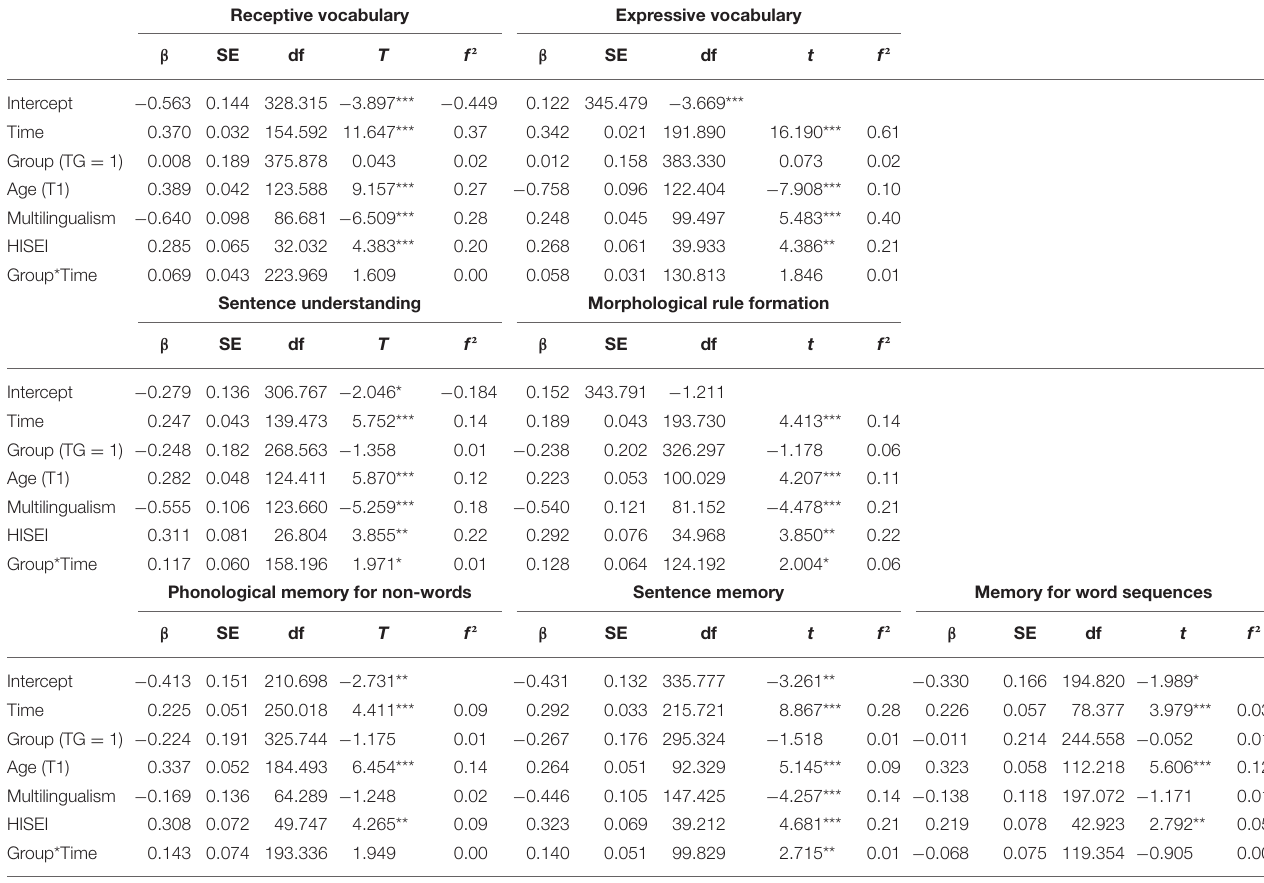
TABLE 3 | Effects of FTT on all language skills over time controlled for age, multilingualism, and HISEI. Receptive vocabulary